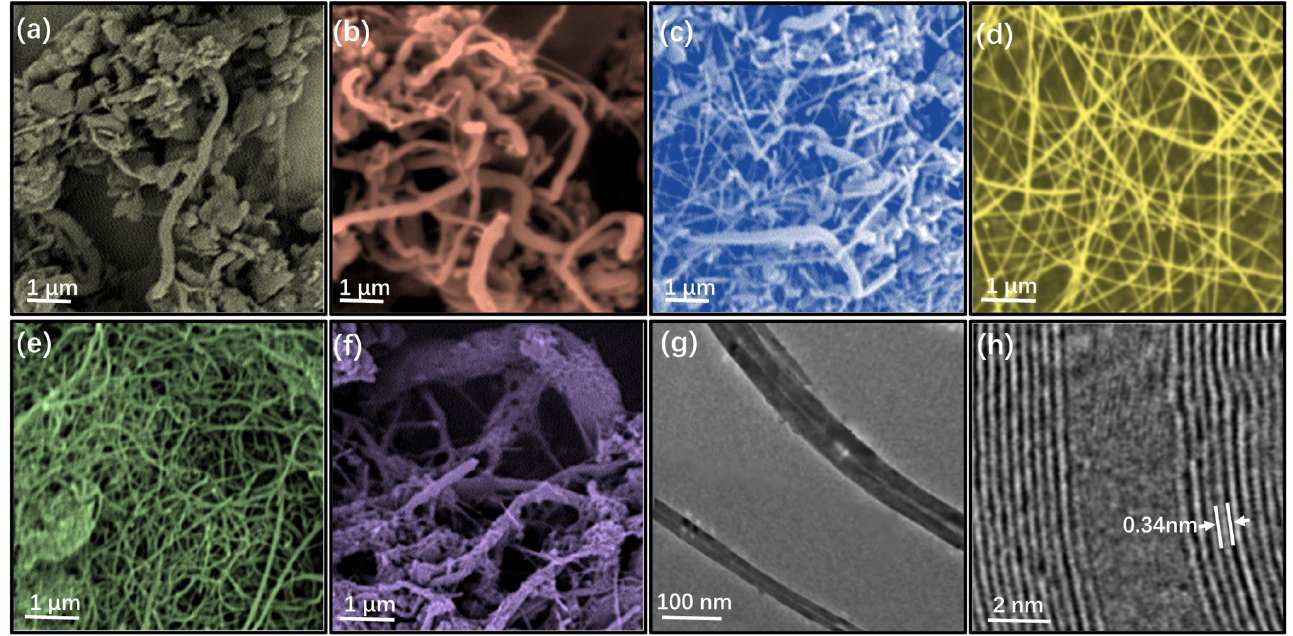
Figure 4. ( a – f ) were SEM images of BNNT synthesized with di ff erent molar content of Fe ( a – f were1%, 2%, 3%, 4%, 5% and 6%, respectively); ( g ) and ( h ) were TEM and HRTEM images of BNNT with Fe content of 4%.